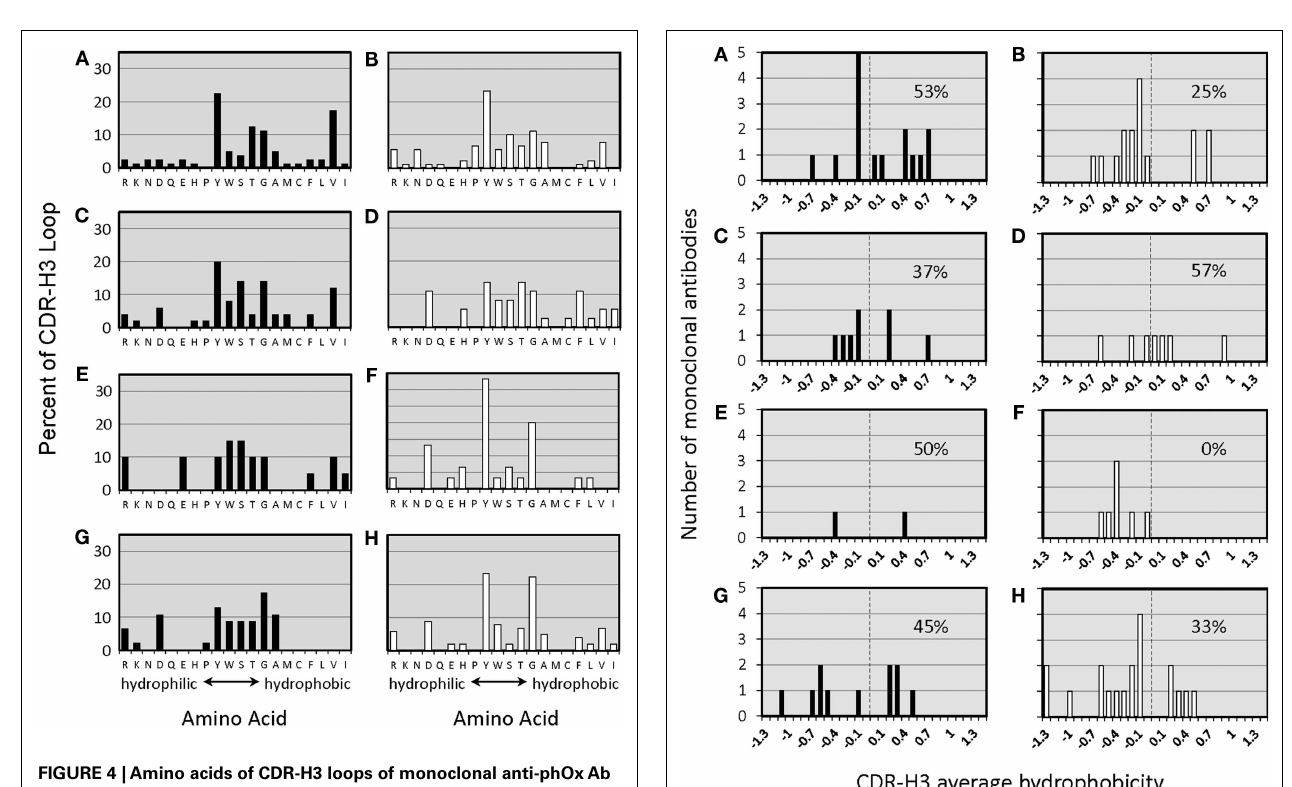
FIGURE 4 |Amino acids of CDR-H3 loops of monoclonal anti-phOxAb of D-altered ∆ D-D µ FS mice . Amino acids are indicated at the x -axis in the one-letter code. Hybridomas secreting anti-phOx antibodies (IgM black bars, IgG white bars) were generated after primary immunization on day 7 (A) IgM ( n = 16 mAb), (B) IgG ( n = 14 mAb), and on day 14 (C) IgM ( n = 8 mAb), (D) IgG ( n = 7 mAb), 3days after secondary immunization (E) IgM ( n = 2 mAb), (F) IgG ( n = 7 mAb), 3days after tertiary immunization, (G) IgM ( n = 11 mAb), and (H) IgG ( n = 17 mAb). See also Figure S3 in Supplementary Material.